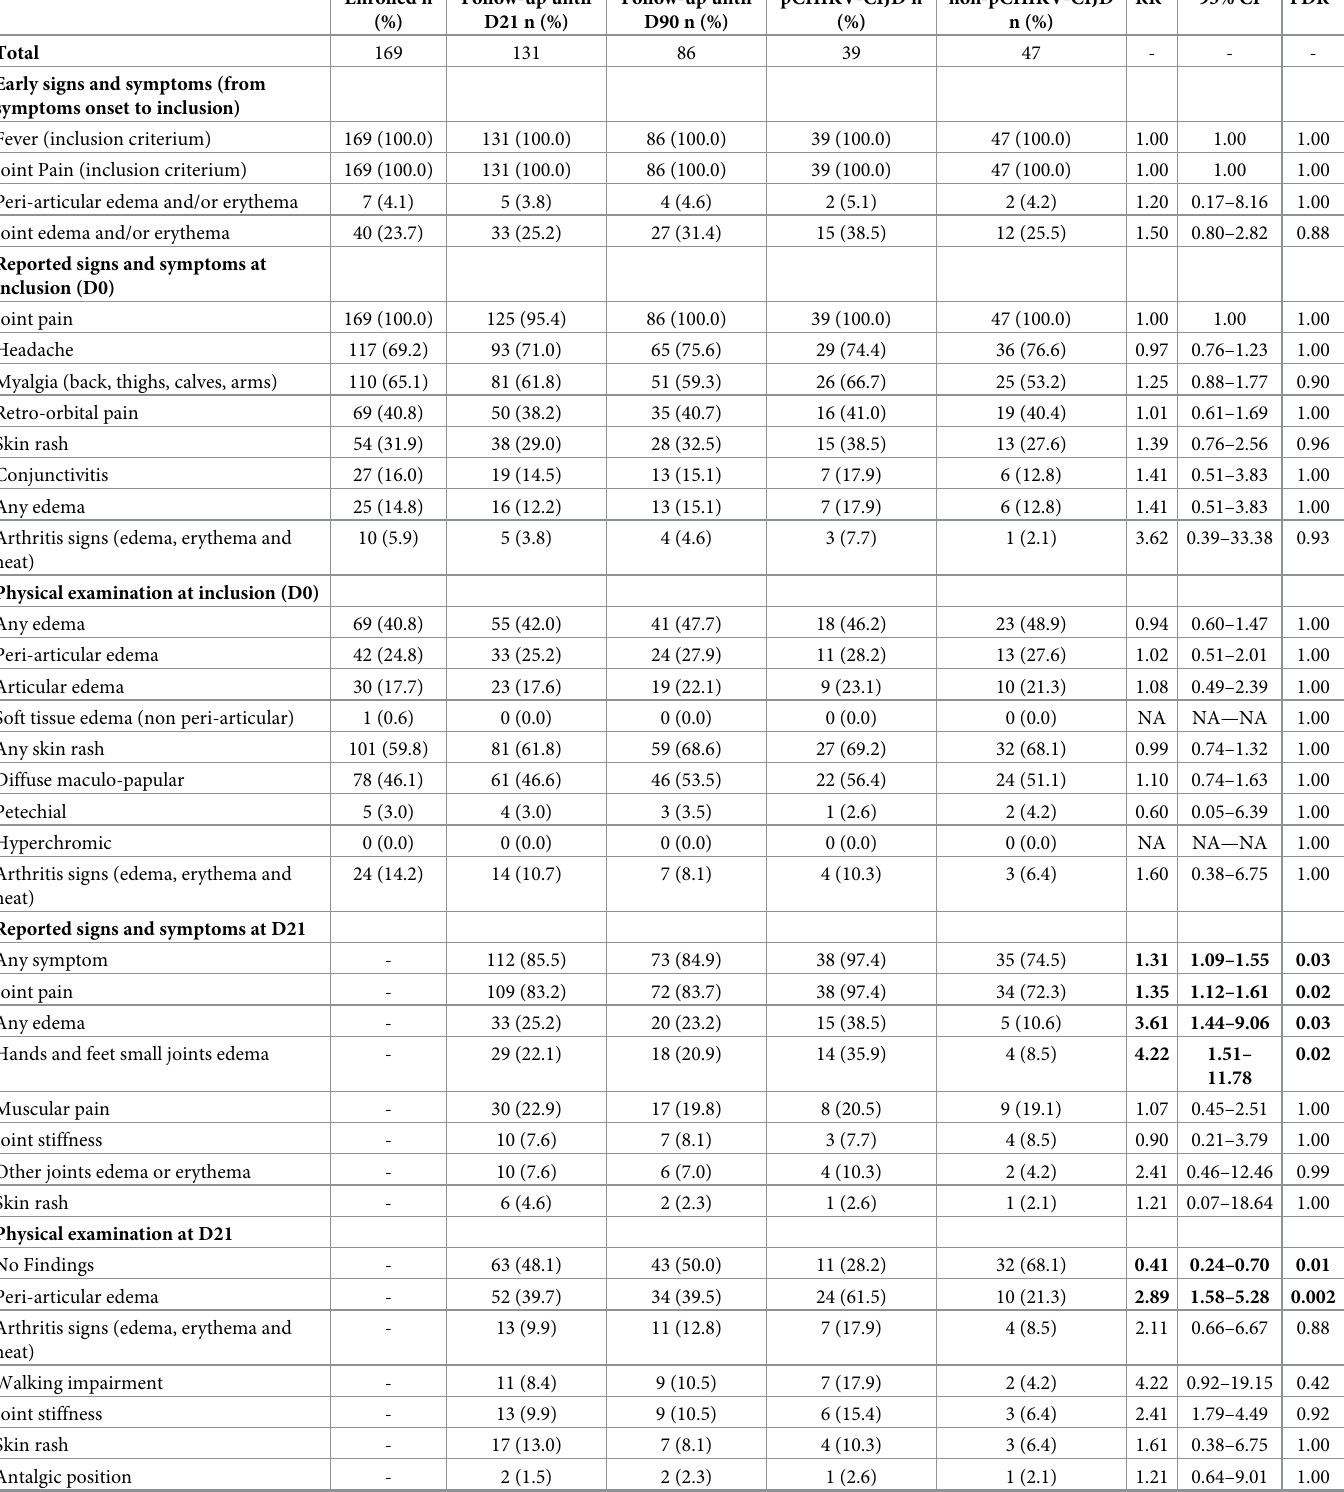
Table 3. Clinical categorical variables and univariate analysis from CHIKF–confirmed patients at D0 and